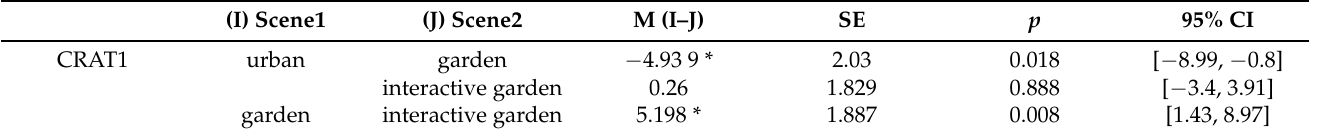
Table A5. Paired comparison results of